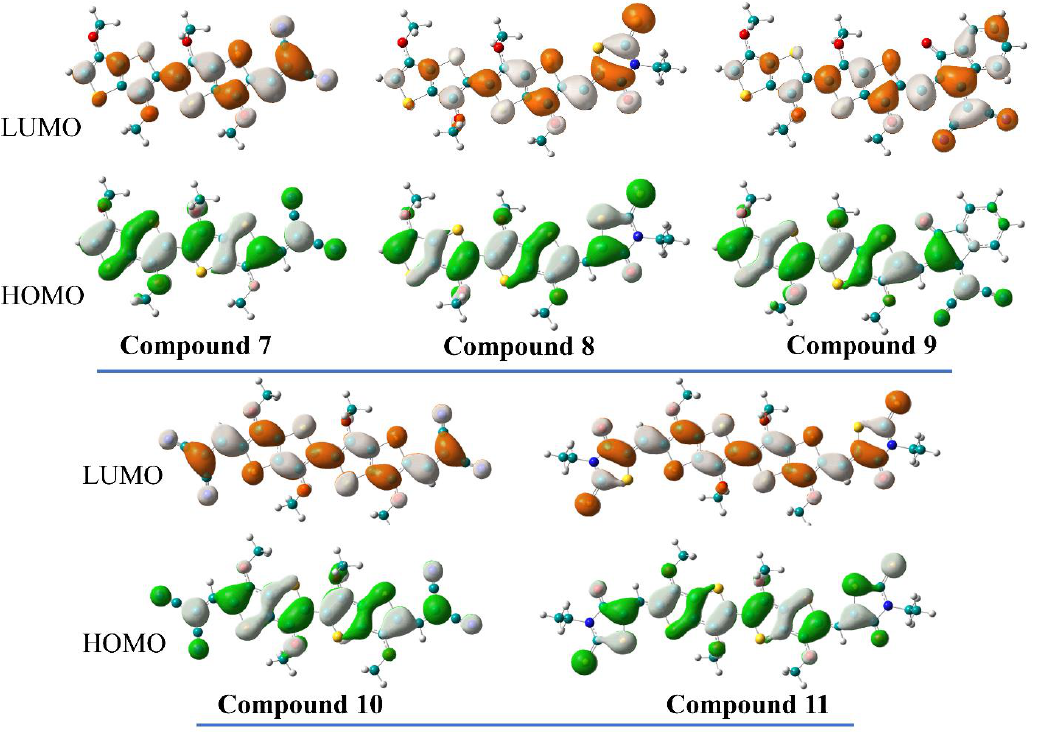
Figure 5. Distribution of HOMO and LUMO canonical orbitals in compounds 7 – 11 (isovalue = 0.02).